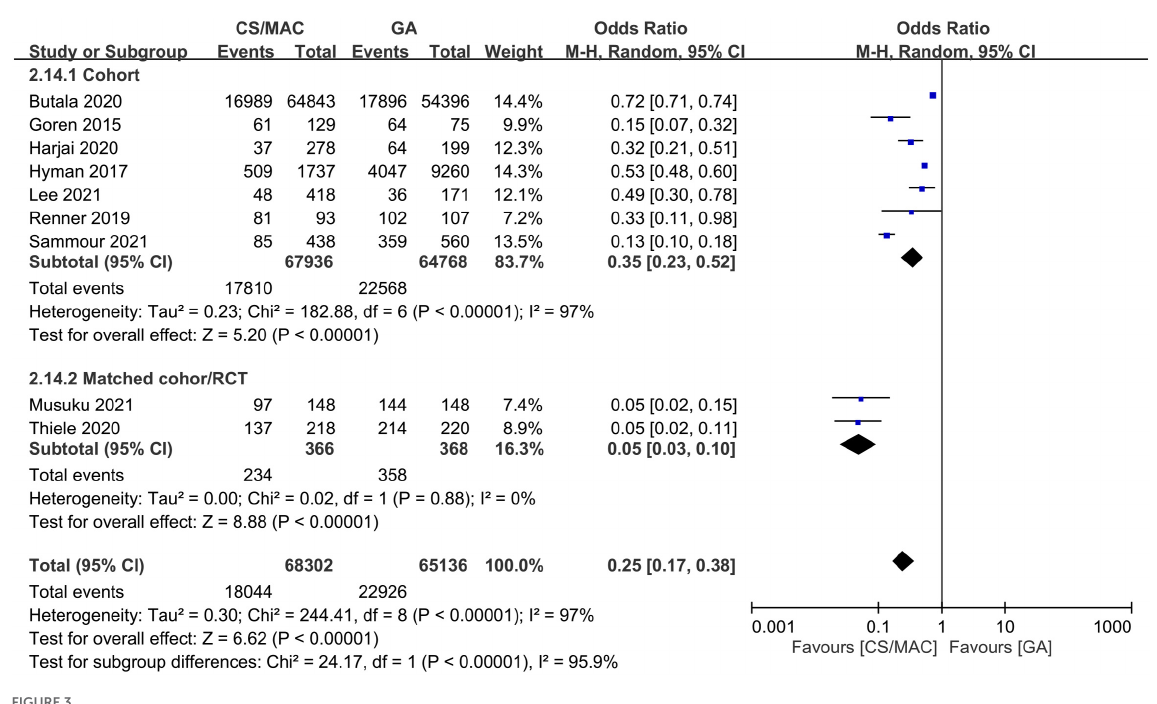
FIGURE3 Forest plot comparing the risk of vasopressor/inotropic support in patients receiving conscious sedation/monitored anesthesia care (CS/MAC) or general anesthesia (GA). CI, confidence interval; M-H,